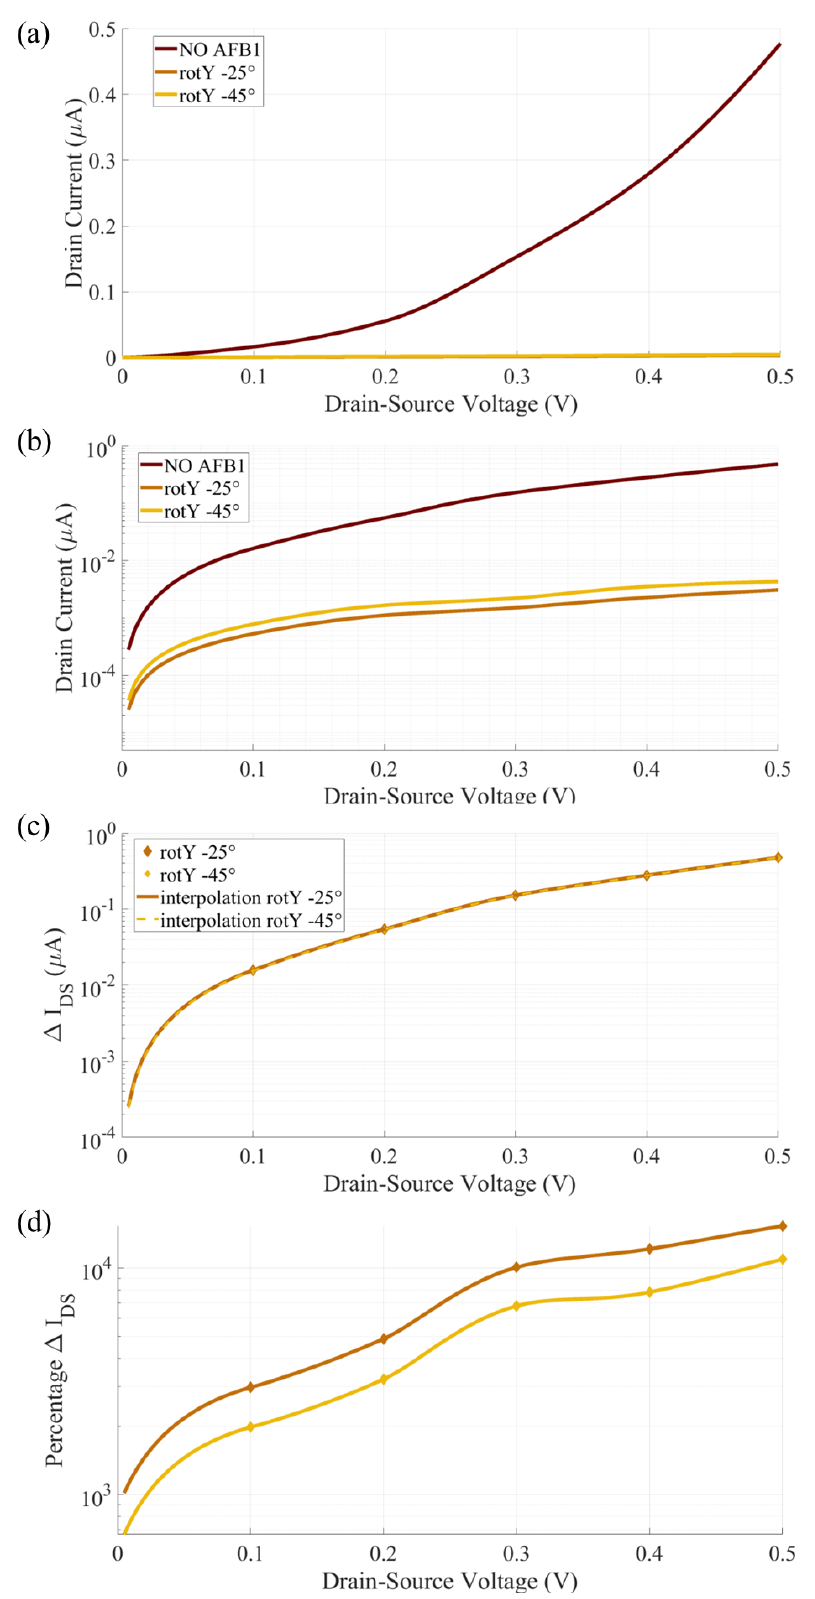
Figure 9. Computed current response in linear ( a ), semi-logarithmic scale ( b ), ∆ I DS ( c ) and ∆ I DS % ( d ) of Au-8PyDT FET sensor for V GS = 4.75 V without (dark red) and with the AFB1 target (yellow and brown